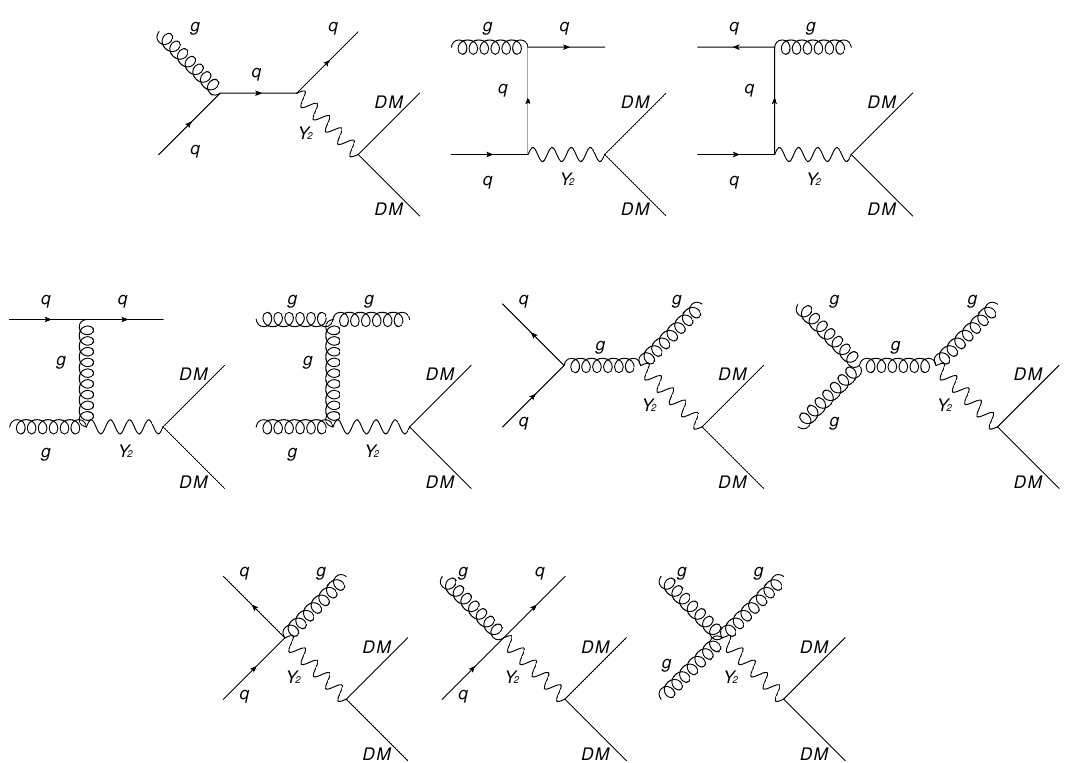
Figure 23: Feynman diagrams for DM production with a monojet in the spin-2 me- diator